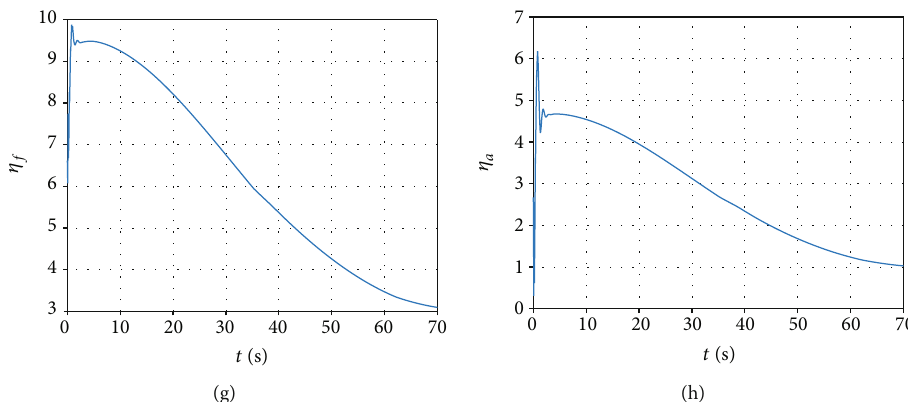
Figure 3: Response of SCFDM without disturbances and perturbation. (a) The response of velocity. (b) The response of the angle of attack. (c) The elevator de fl ection. (d) The equivalence ratio. (e) The pitch rate. (f) The pitch angle. (g) The generalized modal coordinate of the forward beam. (h) The generalized modal coordinate of the afterward